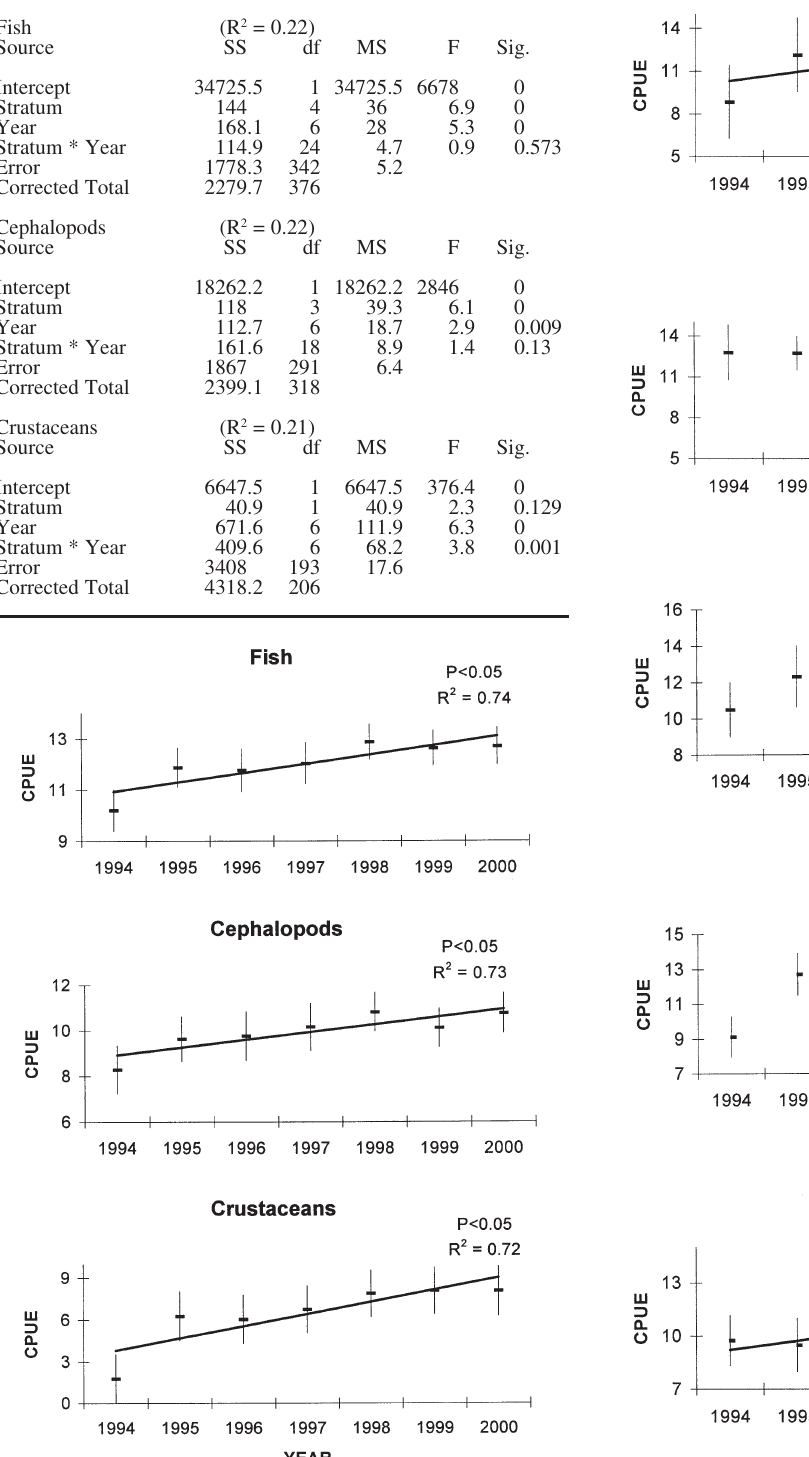
F IG . 6. – Standardised CPUE estimates expressed in ln (g/km 2 ) by year and faunistic category for all MEDITS species. Vertical lines indicate the 95% confidence intervals of the corresponding estimates. Trend-lines indicate the presence of significant trends.